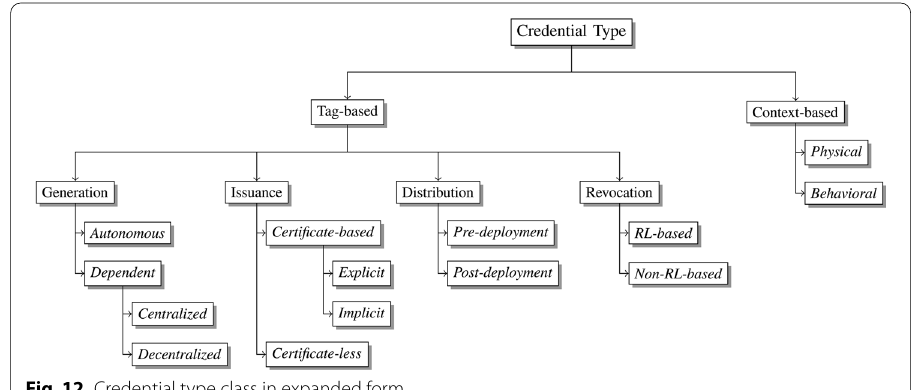
Fig. 12 Credential type class in expanded